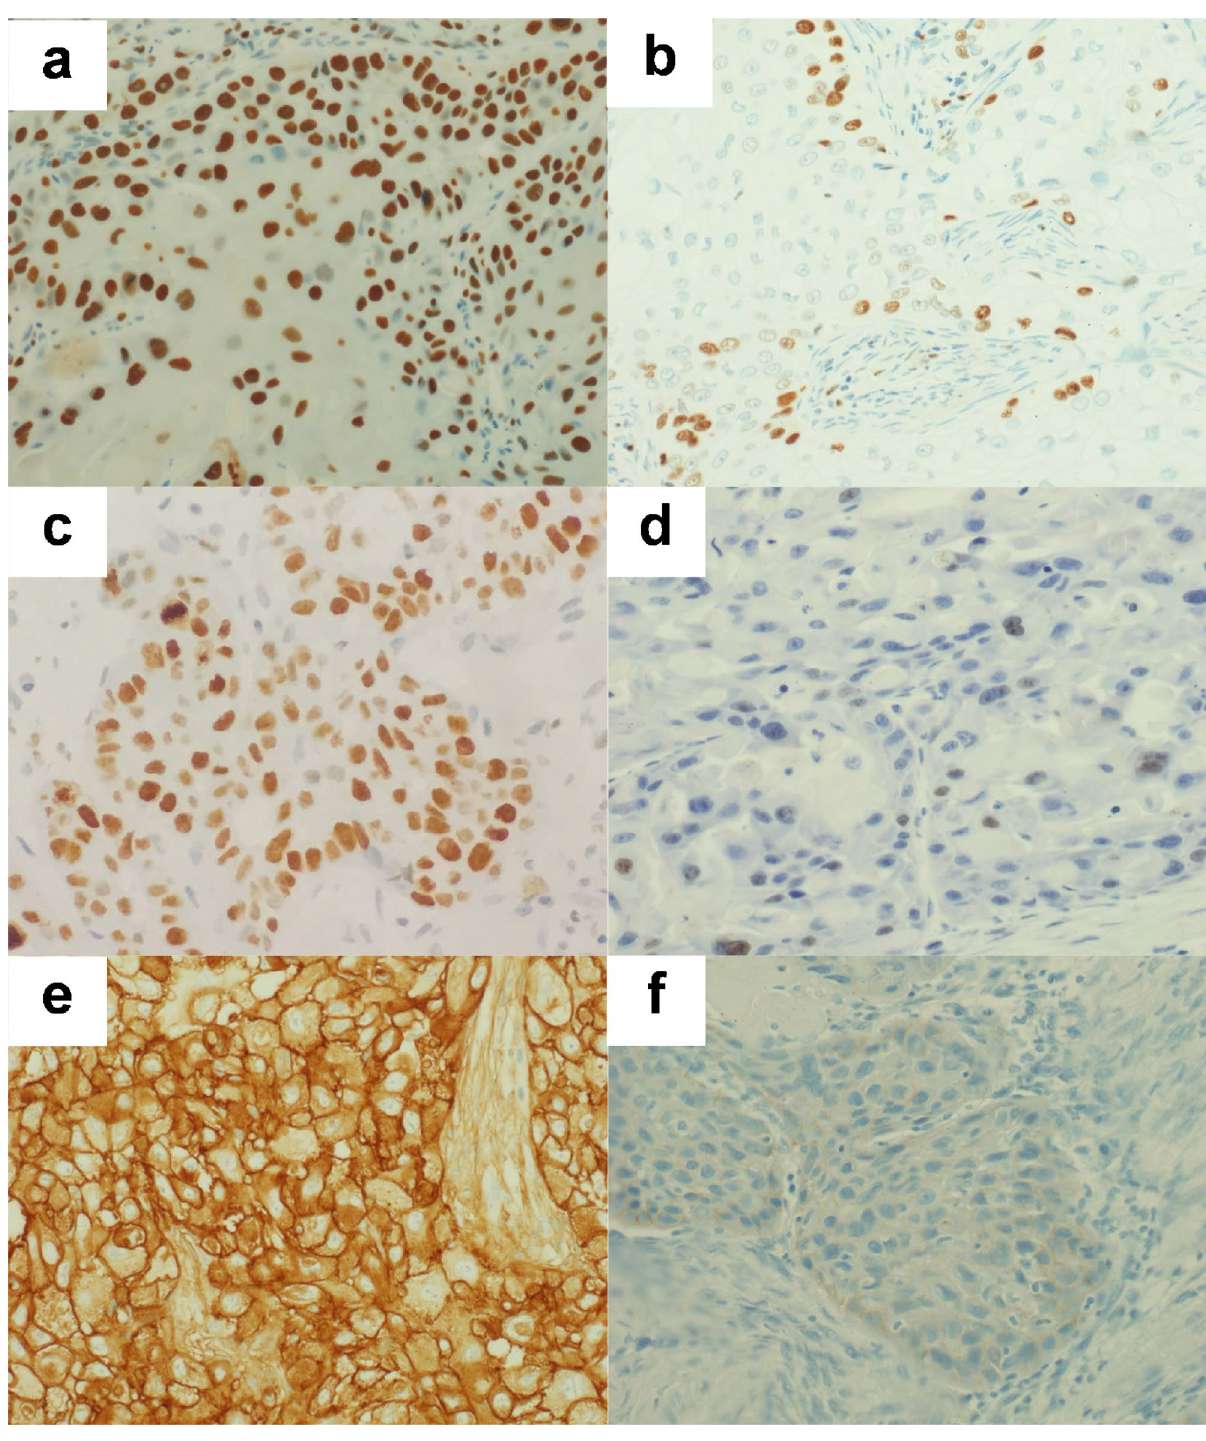
Figure 1. MCM-2, Ki-67 and EGFR immunoreactivity in representative laryngeal samples. Immunodetection performed using nuclear staining for MCM-2 ( a , b ) and Ki-67 ( c , d ), and membranous staining for EGFR ( e , f ) labeling in laryngeal squamous cell carcinoma. There are strong reaction in early stage ( a , c , e ), while MCM-2, Ki-67 and EGFR expressions are downregulated in advanced stage ( b , d , f